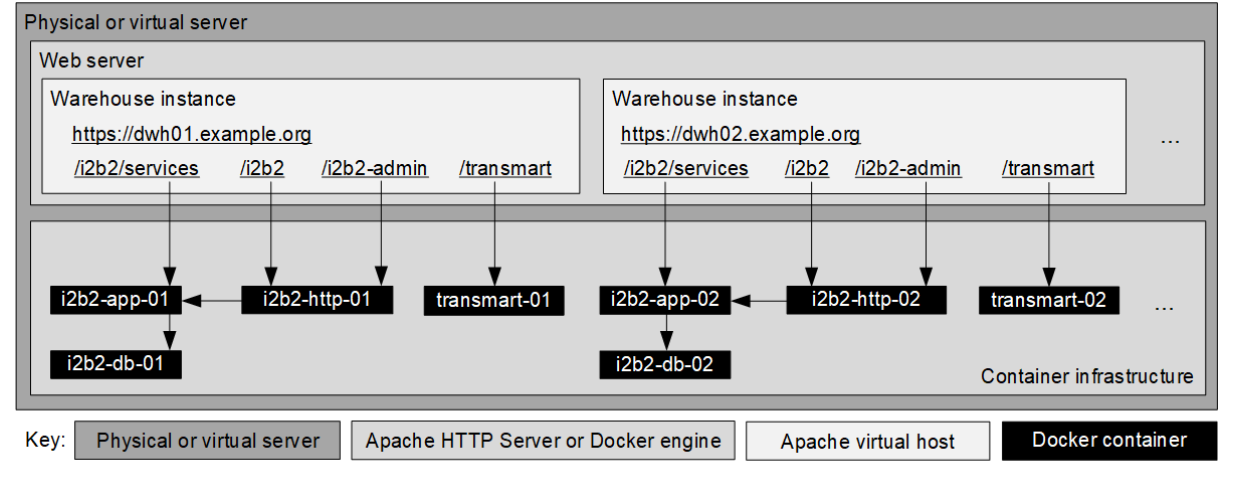
Figure 2. Schematic overview of the components for the provisioning of multiple warehouse instances and their